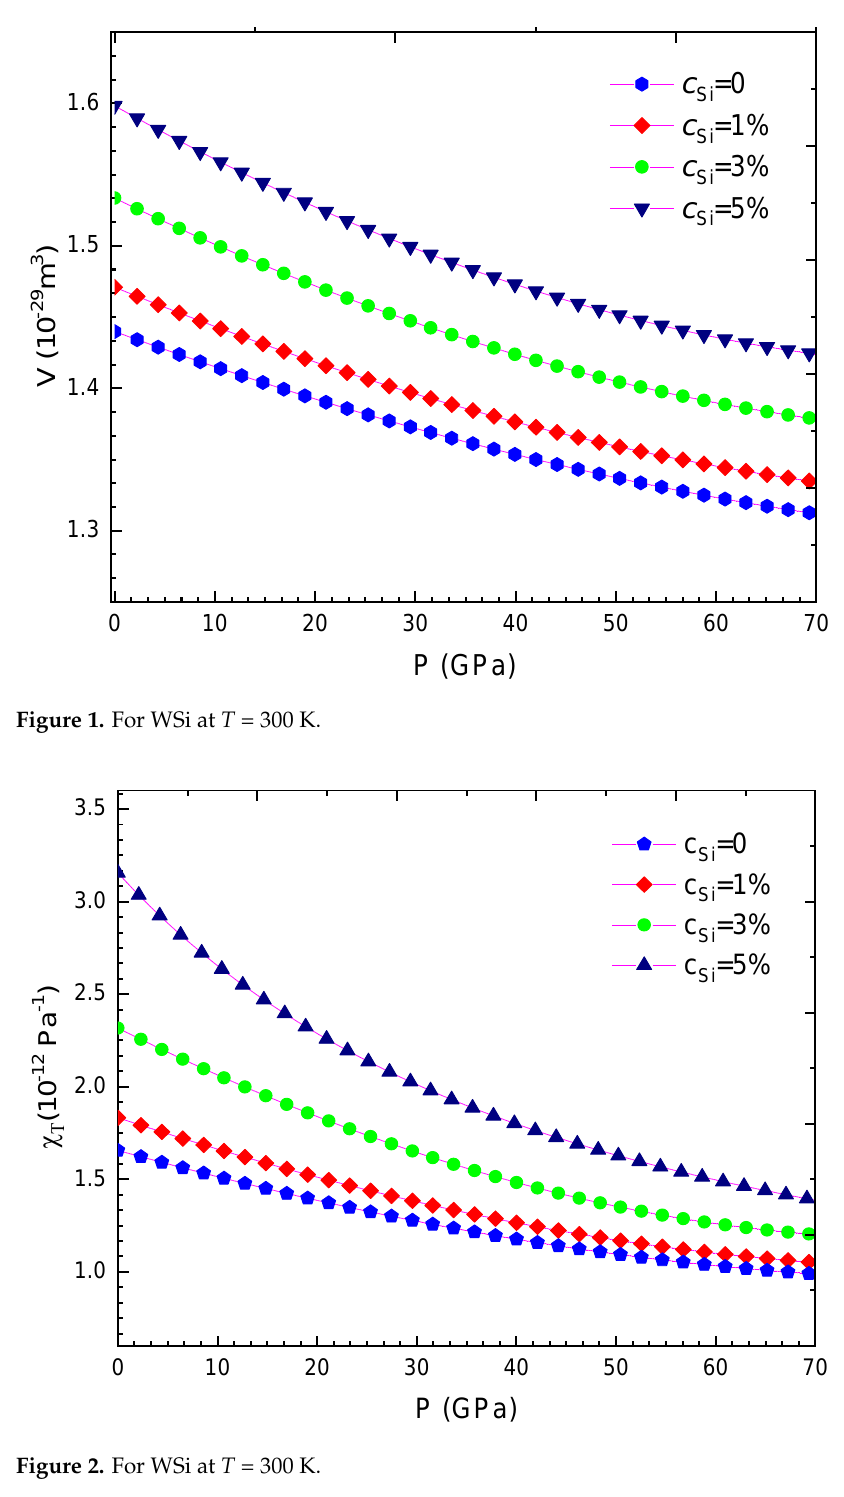
Table 3. Si concentration and pressure dependence of isothermal compressibility